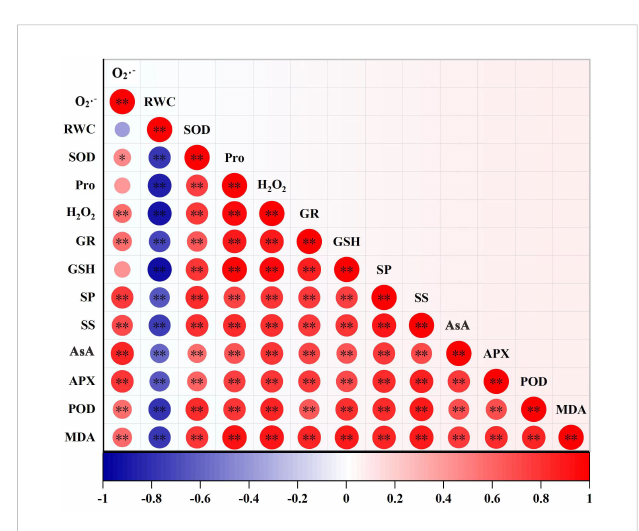
FIGURE 6 Pearson correlation between indicators. The deepness of color indicates the strength of the correlation, blue indicates negative correlation, and red indicates positive correlation, * p < 0.05, ** p < 0.01. (RWC, leaf relative water content; MDA, malondialdehyde; Pro, proline; SS, soluble sugar; SP, soluble protein, O 2· – , accumulation of superoxide anion; H 2 O 2 , hydrogen peroxide, SOD, superoxide dismutase; POD, peroxidase; AsA, ascorbic acid; GSH, glutathione; APX, ascorbate peroxidase; GR, glutathione